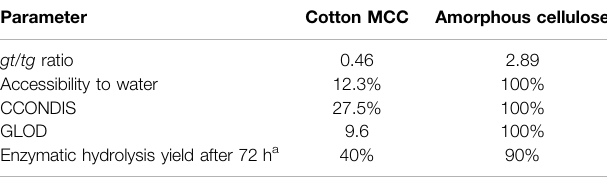
TABLE 5 | Comparison of Raman parameters and enzymatic hydrolysis yields.